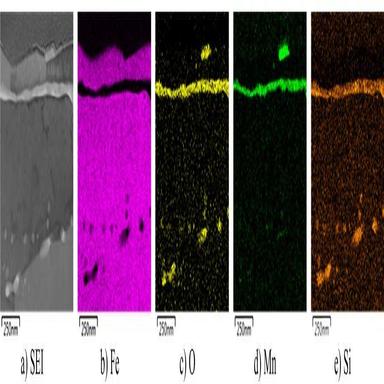
TEM EDS elemental mapping of the oxidized-reduced sample for area 2 in. a) SEI, b) Fe, c) O, d) Mn, e) Si.